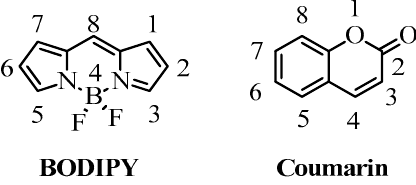
Figure 1. Structure of boron dipyrromethene dyes (BODIPYs) and